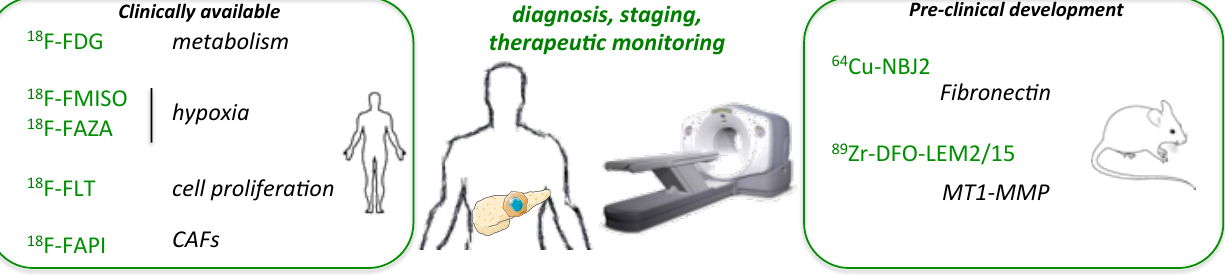
Figure 1. Radiotracers dedicated to diagnosis, staging and therapeutic monitoring of